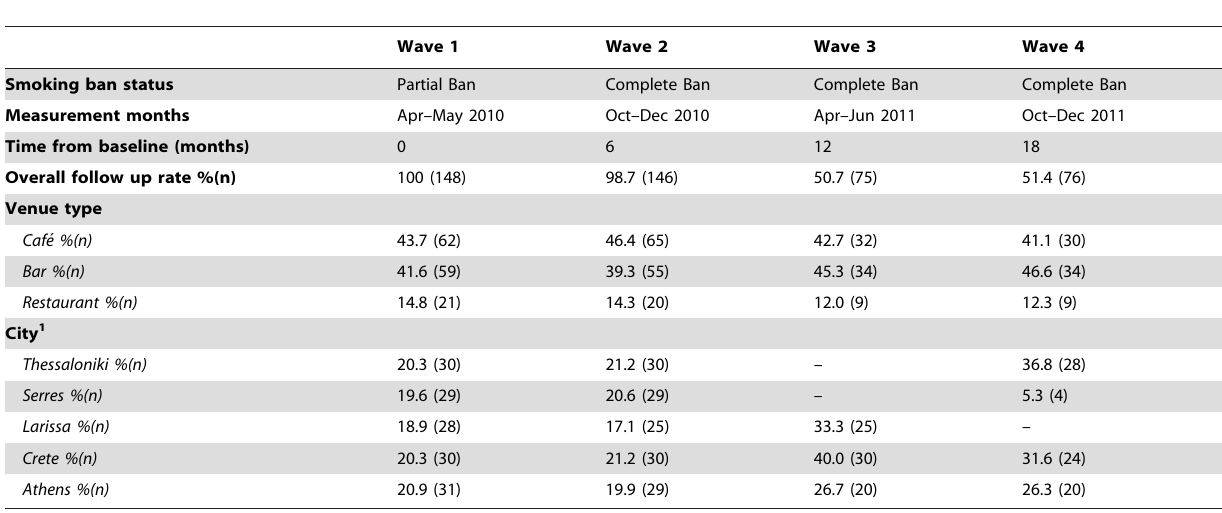
Table 1. Characteristics of the Hellenic Air Monitoring Study by wave and site, Greece, 2010–2011.